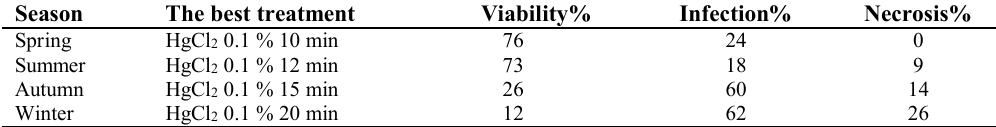
Table 3. Sterilization treatments of E. globules buds.